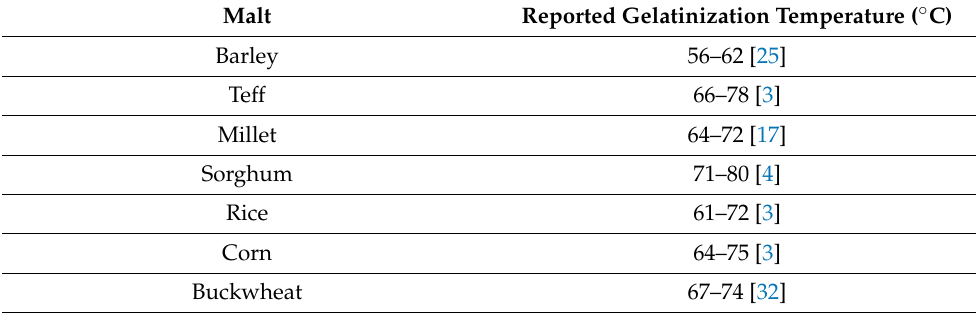
Table 2. Reported gelatinization temperatures for barley and gluten-free malts.